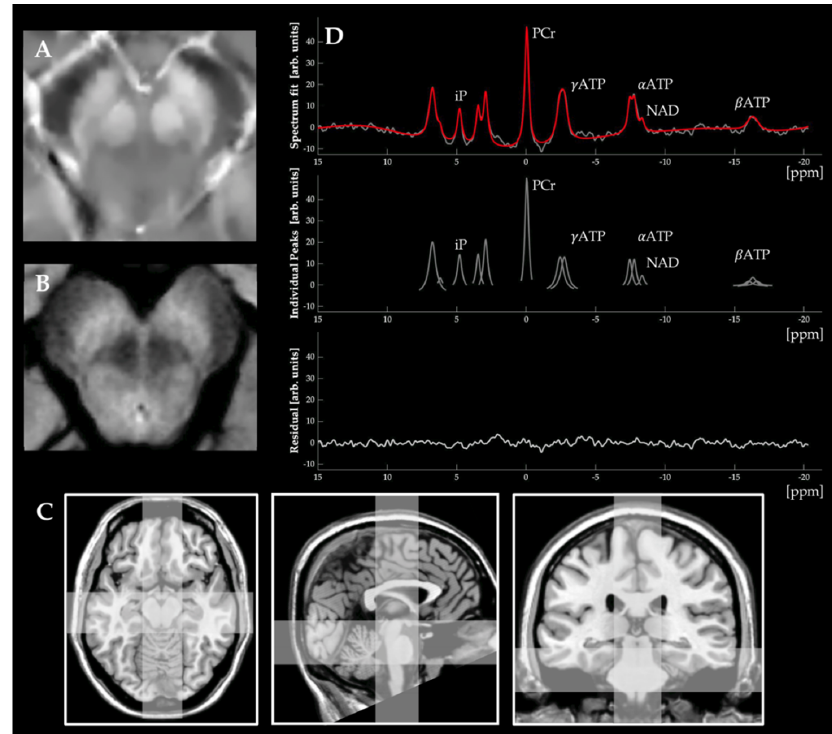
Figure 2. Examples of neuroimaging-based approaches to map iron-, NM-, and mitochondrial dysfunction. In Panel ( A ), we demonstrate an example of a QSM image of non-diseased midbrain (axial plane). In Panel ( B ), we demonstrate an example of an NM-weighted image of non-diseased midbrain (axial plane). Both images illustrate the spatial resolution and structural configuration of the SNpc, which can be achieved using clinical standard scanners (Siemens MAGNETOM Skyra, 3T, 64 channel head coil). In Panel ( C ), we exemplarily highlight the spatial resolution and voxel placement of 31 P-MRSI measurements in the axial, sagittal, and coronal planes (from left to right). In Panel ( D ), the typical workflow of 31 P-MRSI measurements can be seen. The acquired spectrum of a given voxel (upper panel, gray color) is interpreted by incorporating prior knowledge (spectrum fit, upper panel, red color). Here, the three different ATP peaks ( α ATP, β ATP, and γ ATP) result from the three phosphate nuclei in an ATP molecule. Single peaks of known metabolites can be semi- quantified by calculating the area under the curve (middle panel). The residuals (lower panel) can be interpreted as a quality measure for the spectrum fit. 31 P-MRSI: 31 phosphorus magnetic